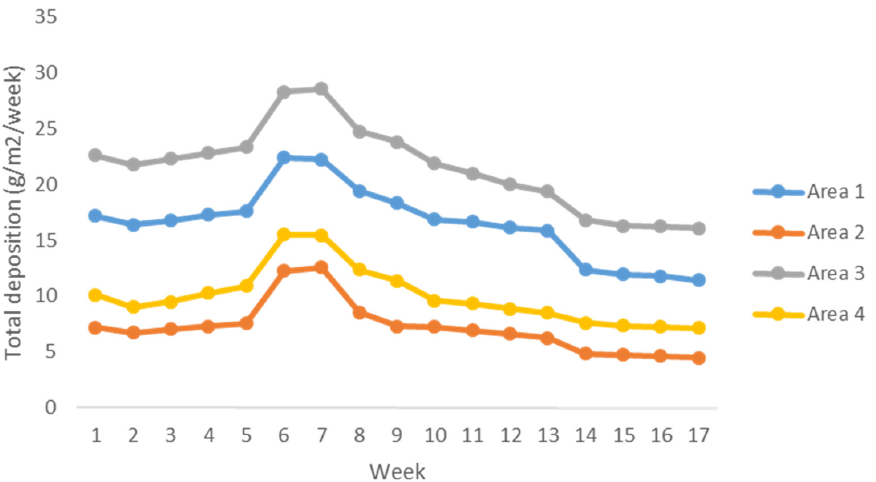
Figure 4. Total depositions in the four areas in the dry season only.